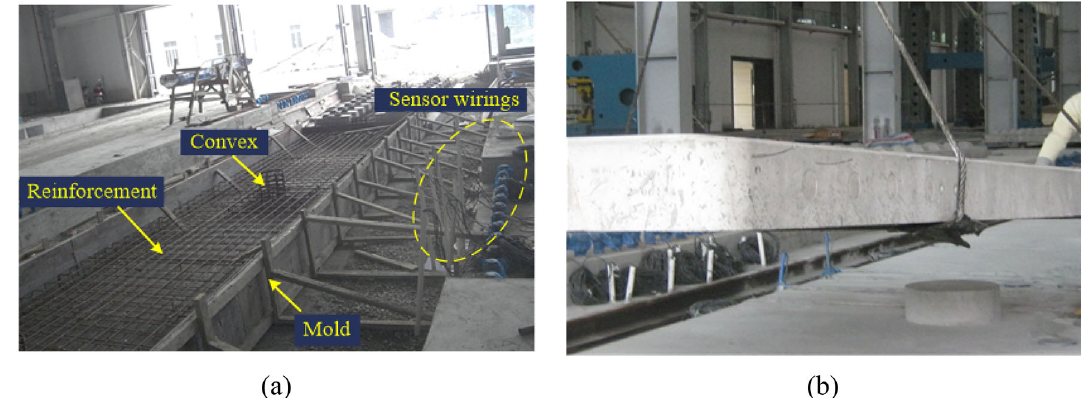
Fig. 7 Construction of concrete base and slab for CRTS I slab track system: a arrangement of reinforcement; b layout of prefabricated slab